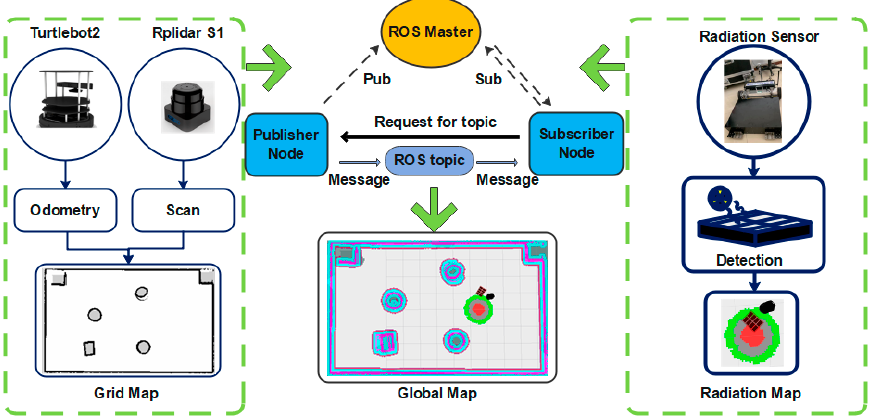
Figure 4. Map fusion framework.